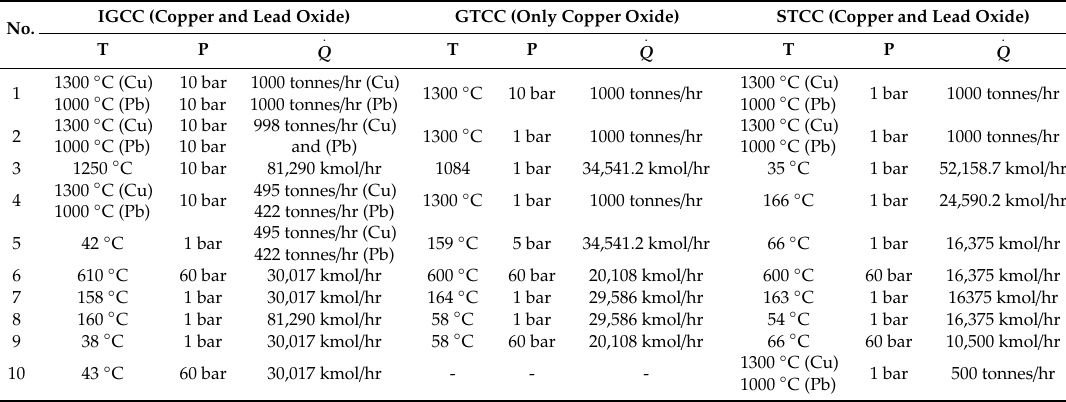
Table 2. Specification and characteristics of the IGCC, GTCC and